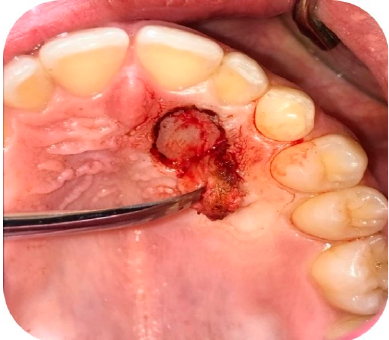
Figure 4. Exposure of the palatally impacted canine with a Prichard periosteal elevator.